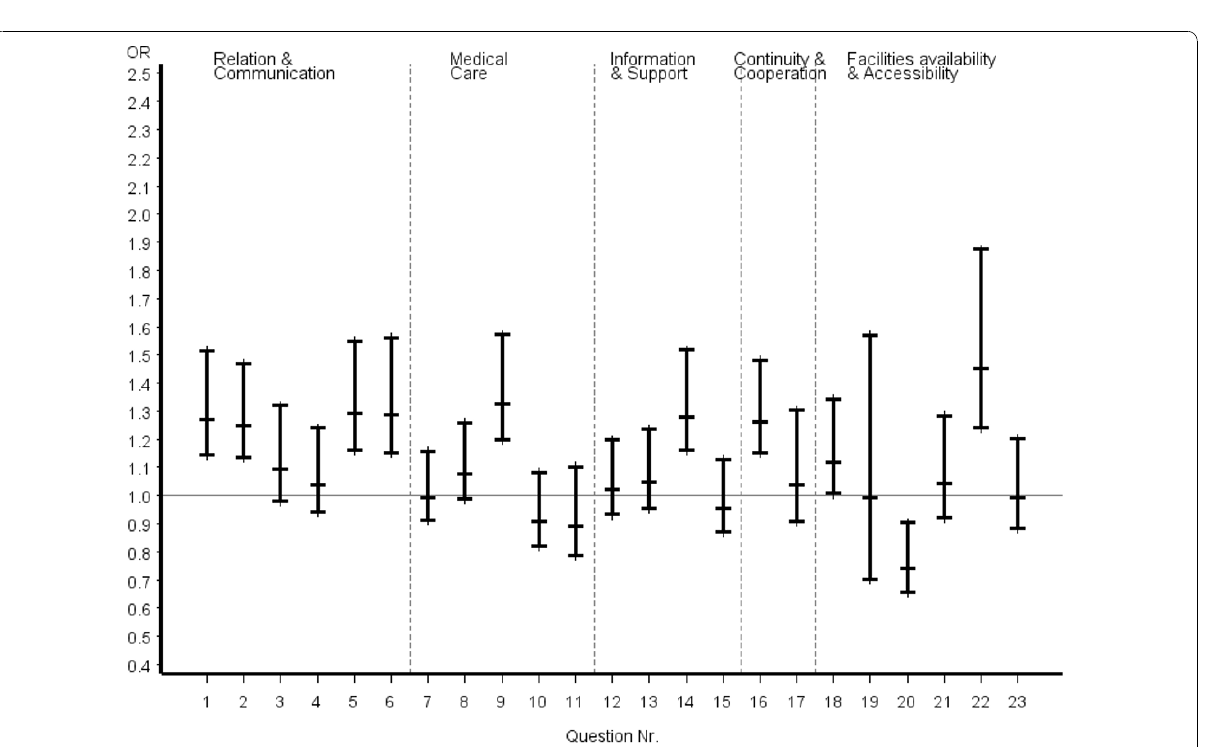
Figure 4 ..Europep questionnaire, odds ratios of most favourable answer option (certified CAM vs. COM) Stratified analysis of patients with chronic conditions . Errorbars denote 95% confidence intervals of odds